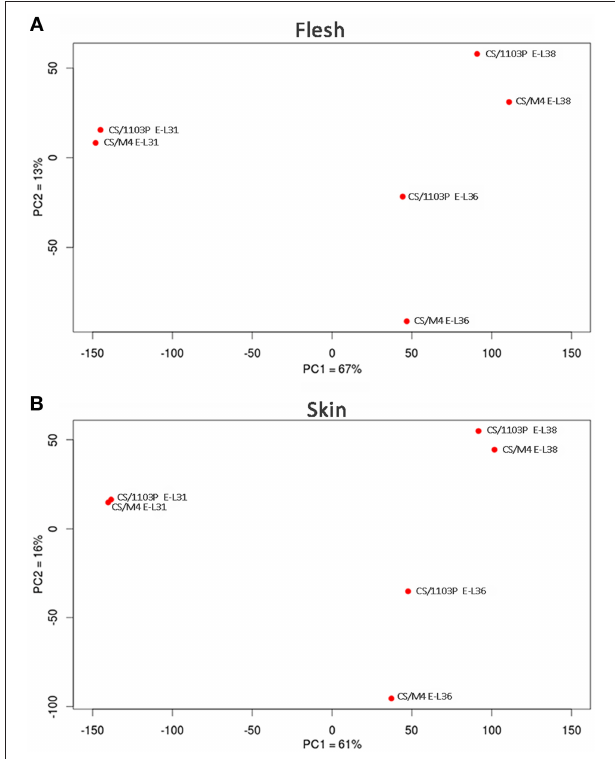
FIGURE 2 | Bidimensional PCA plot of row transcriptome data. Cabernet Sauvignon (CS) grafted onto 1103P (CS/1103P) and M4 (CS/M4) samples distribution according to PC1 and PC2. Two separate PCAs were carried out for flesh (A) and skin (B) mRNA-seq data. Percent of variance is also reported for each component on the corresponding